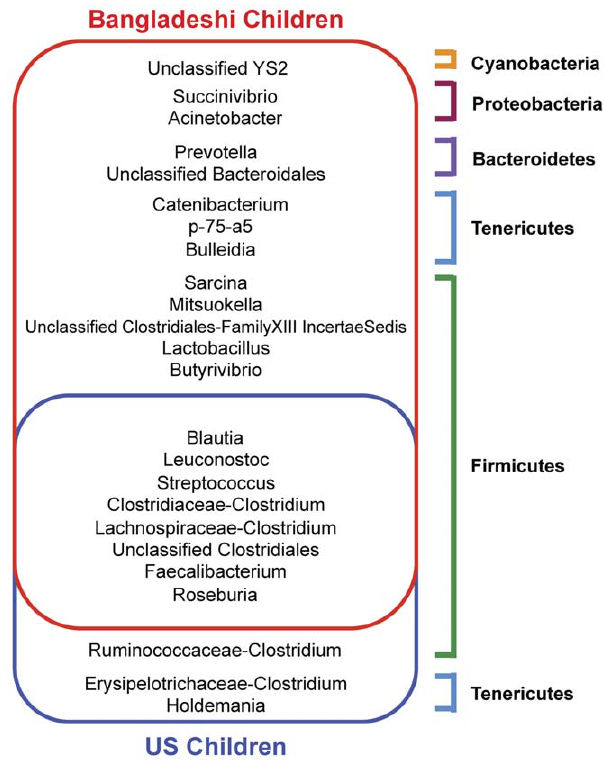
Figure 5. Venn diagram of the exclusive and shared genera of Bangladeshi and U.S. children based on V1–V3 16S rDNA sequence data. The G test of independence was used to determine whether genus presence or absence was associated with one group of children or the other. A list of the most significant genera was compiled based on FDR-corrected p-values. Furthermore, to qualify for a specific country group, the genus had to be observed $ 5 times for each time point within an individual and within all individuals in a country group. The genera exclusively found in Bangladeshi or U.S. children are outlined in red and blue, respectively. The overlapping area between the two groups represents the genera that are shared by all individuals from both countries. The size of each enclosed area is directly proportional to the number of genera that are found in each group. The genera are colored-coded according to the list of phyla on the right. Only U.S. children and Bangladeshi children were included in this